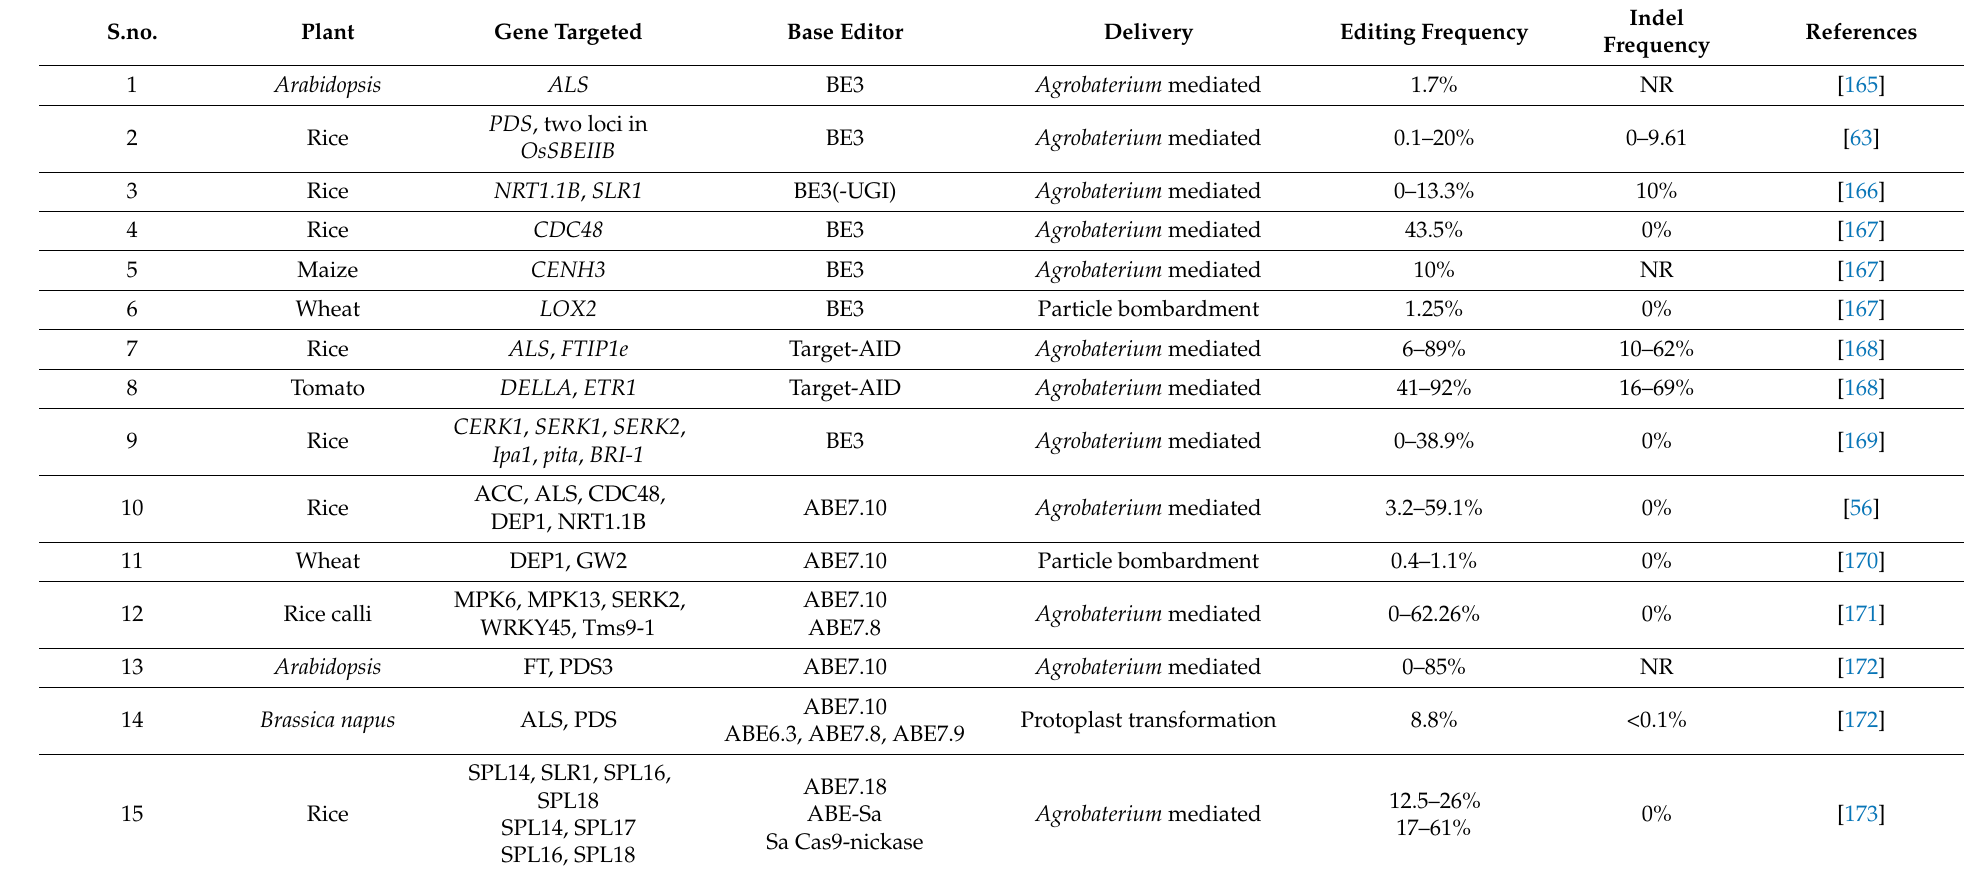
Table 3. CRISPR/Cas-mediated base editing in